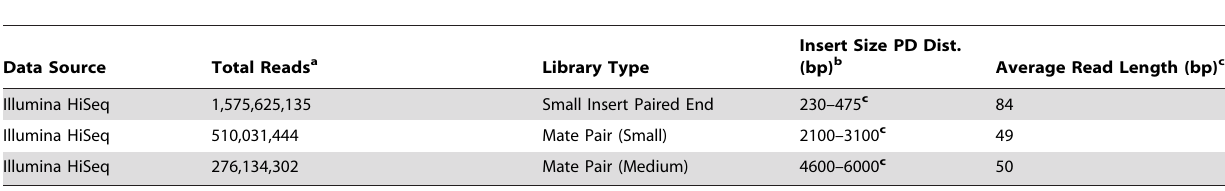
Table 1. Summary of Illumina sequence data used for de novo assembly of the bobwhite genome.